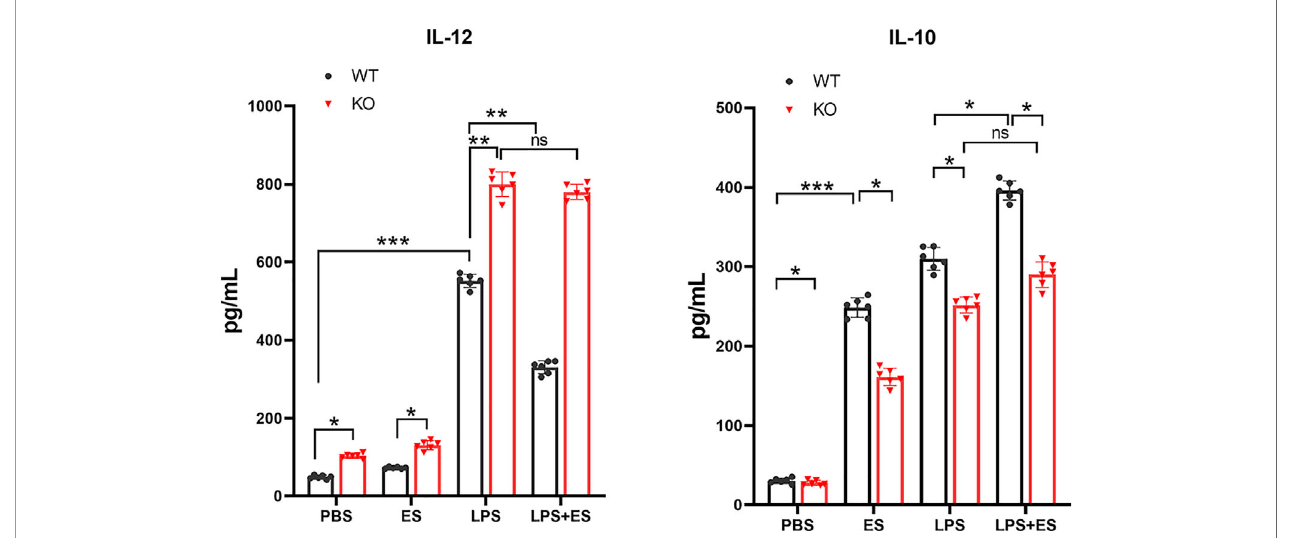
FIGURE 3 | The levels of IL-12 and IL-10 secreted from wild type (WT) or Nrf2 KO macrophages induced by T. spiralis ES. Macrophages were enriched by positive selection with anti- F4/80 magnetic beads. These cells were stimulated with sterile PBS, ES or LPS alone for 24 h. And macrophages were pre-treated with ES (50 m g/ml) for 24 h before stimulation with LPS (100 ng/ml) for 24 h. Cell culture supernatants were collected and stored at − 80°C. IL-12 and IL-10 levels in the supernatant were quanti fi ed by ELISA. Results are presented as the mean ± SD (n=6). *P < 0.05, **P < 0.01, ***P < 0.001, ns, no signi fi cance, as indicated by line (one-way ANOVA with Tukey ’ s post hoc